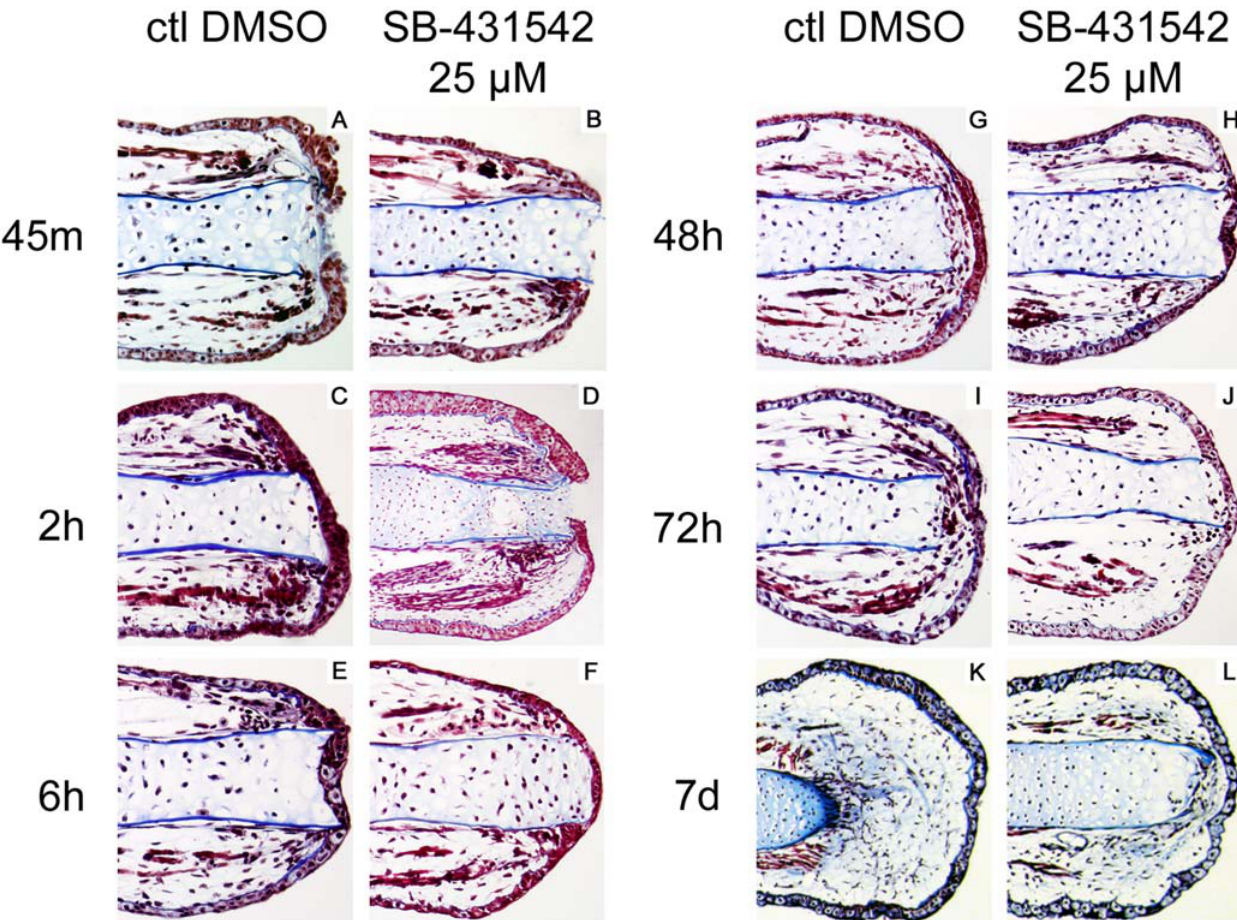
Figure 5. Histological analysis of regenerating limbs treated with SB-431542. Control limbs were treated with DMSO from time of amputation and fixed A) 45 minutes, C) 2 hours, E) 6 hours, G) 48 hours, I) 72 hours and K) 7 days after amputation. Samples treated with 25 m M SB-431542 from time of amputation were fixed at B) 45 minutes, D) 2 hours, F) 6 hours, H) 48 hours, J) 72 hours and L) 7 days after amputation. Masson’s trichrome staining method was used to stain cell cytoplasm in red, collagen in blue and nuclei in black. Note the delayed closure of the wound epithelium in SB- 431542 treated limbs at 45 minutes and 2 hours post-amputation. Also note that there is no blastema formation or accumulation of cells between the tip of the bone and the wound epithelium in SB-431542 treated